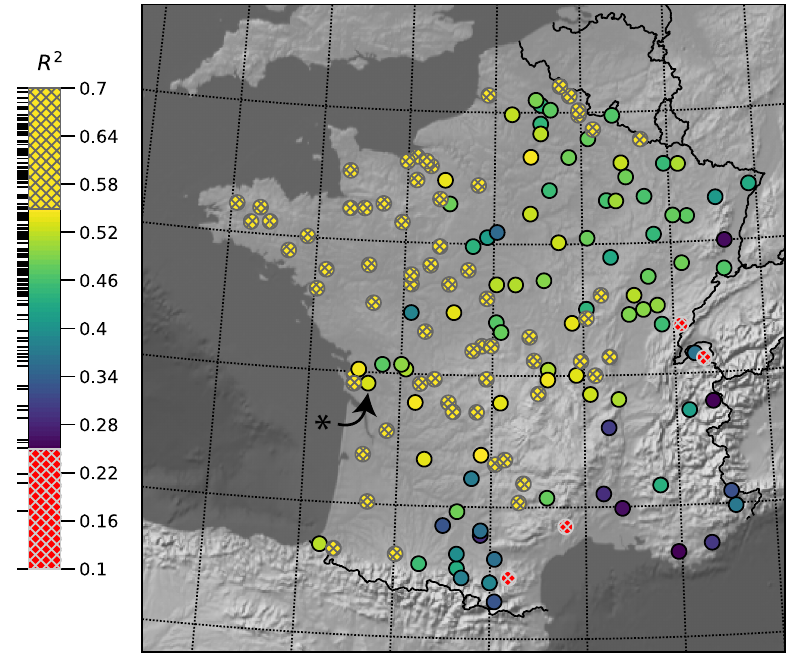
Figure 10. R 2 of retrieved vs. SURFEX SM estimates for retrieval with auxiliary LAI ( ∝ τ ) input. To increase contrast, the color-range is reduced to ( R 2 selected in Figures 15 and 16.